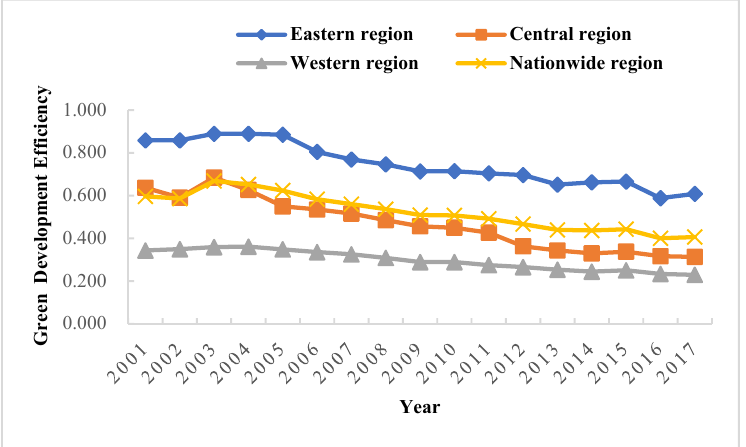
Figure 2. Green development efficiency under the meta-frontier of east, central, and west China.